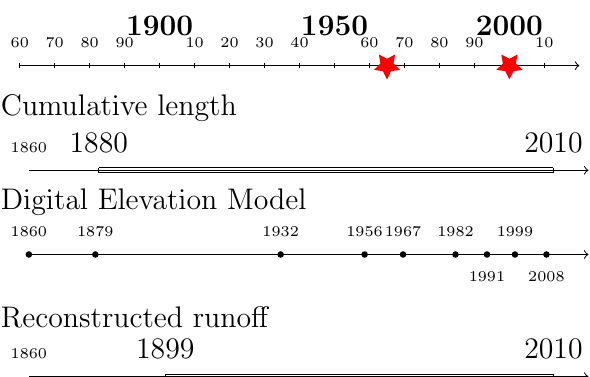
Fig. 5. Timeline of the available data for Allalingletscher. Stars in- dicate the occurrence of the break-offs.